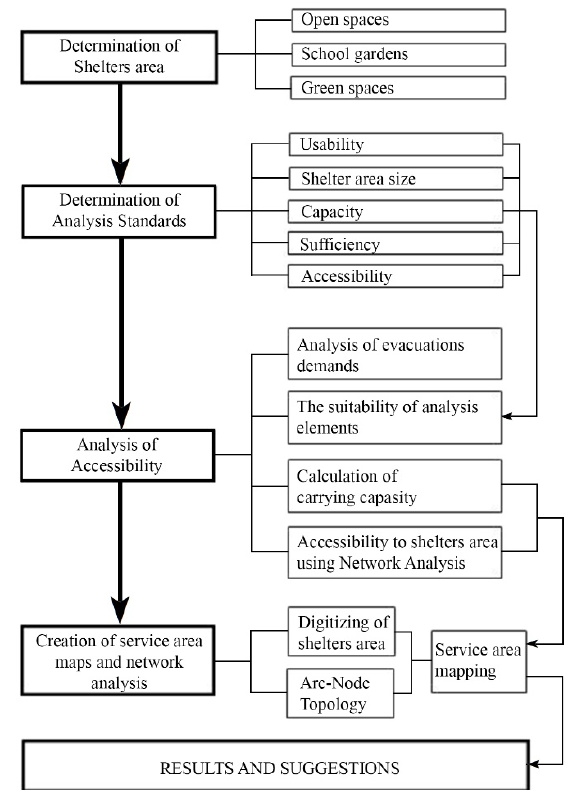
Figure 3. Flow chart of the methodology